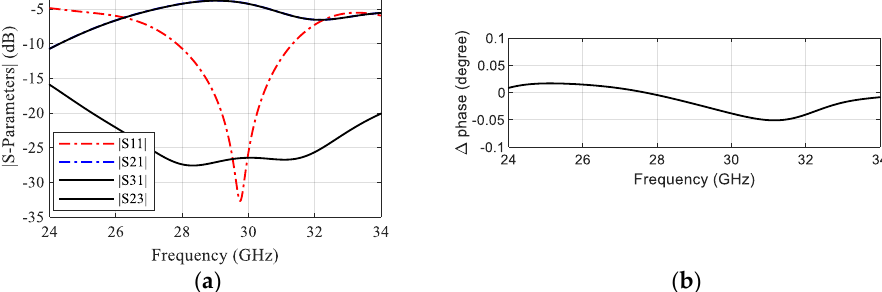
Figure 1. Power splitter configuration.